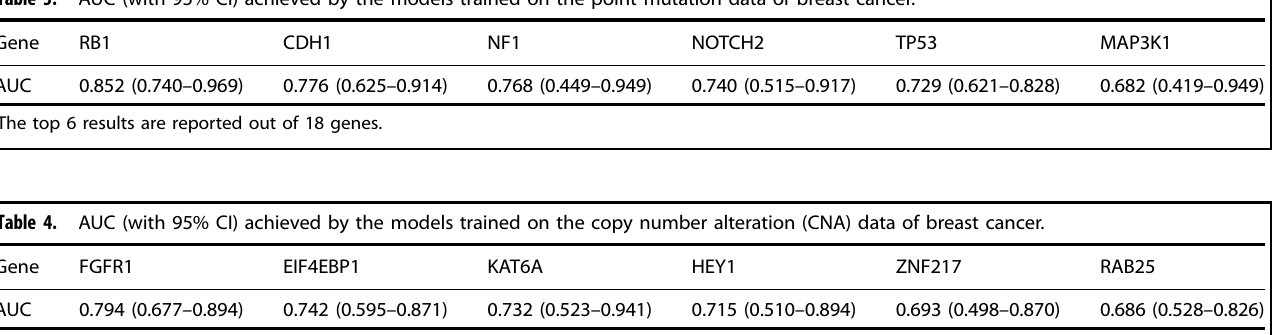
Table 3. AUC (with 95% CI) achieved by the models trained on the point mutation data of breast cancer. Gene RB1 CDH1